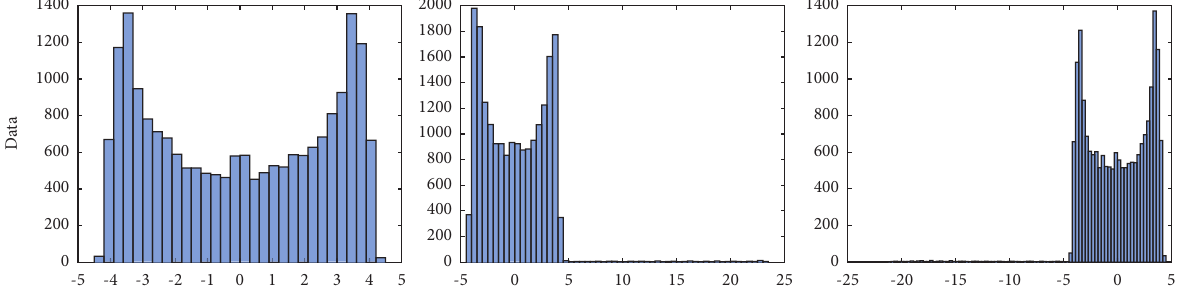
Figure 4: Data comparison.